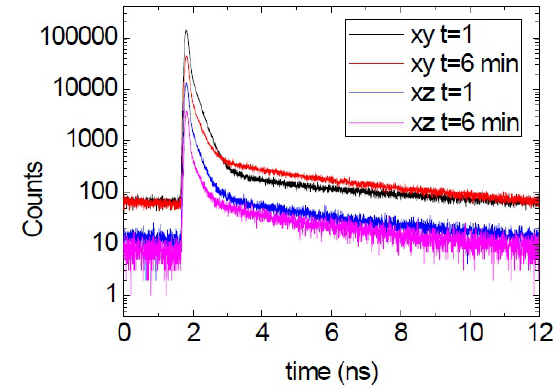
Figure 8: Average lifetime curves of the luminescence in xy and xz scanning mode for t=1 and t=6